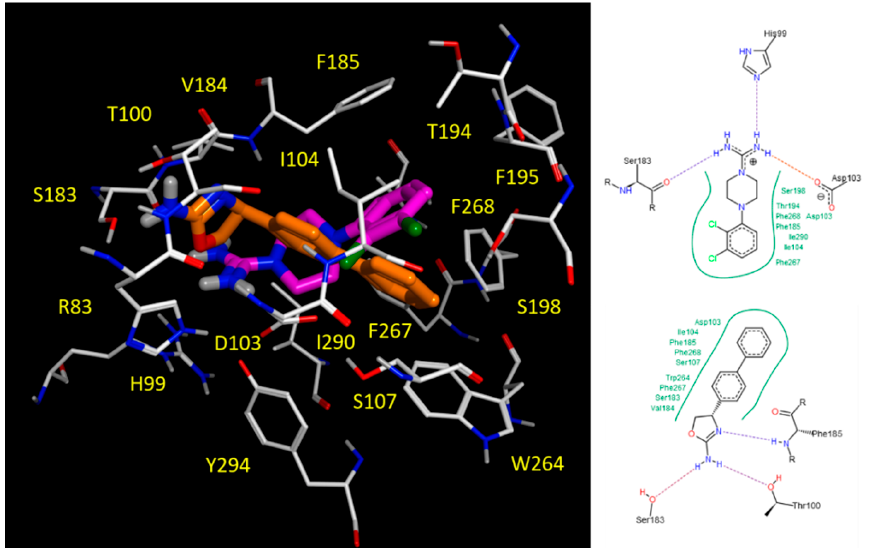
Figure 13. Docking positioning of the amidine-containing derivatives 15 ( C atom; magenta) and of the oxazoline 30b ( C atom; orange) as h TAAR1 agonists at the receptor crevice ( left ). Ligands are shown as sticks. The most relevant residues are labelled. A schematic perspective of the most relevant H-bonds experienced by the two agonists is also shown ( right ).